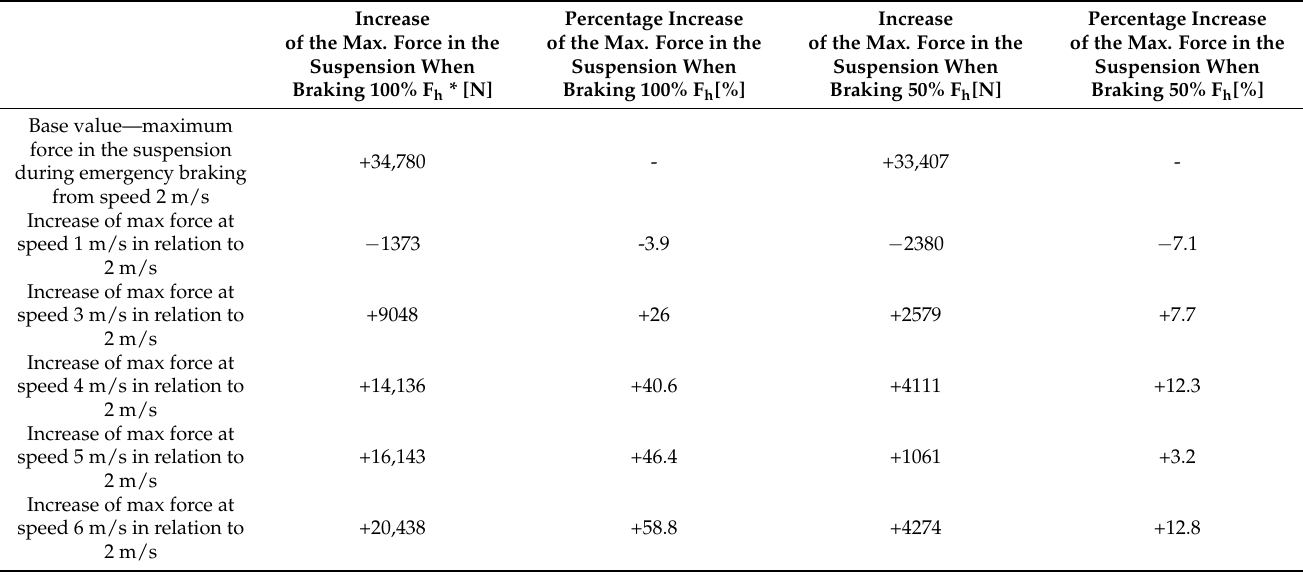
Table 5. Increase of maximum force in the most loaded suspension in relation to the force recorded during emergency brake from the speed 2